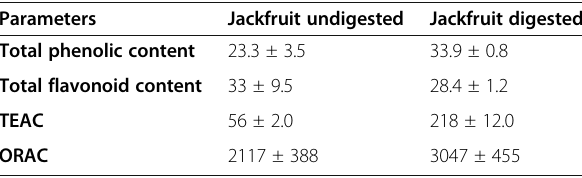
Table 2 Uses of different jackfruit parts [20, 37] Plant part Use Fruit Food: Vegetable, pickle, chutney, jam, jelly, paste, candies, juice, powder, confectionery Seed Eaten boiled, roasted and salted as table nuts, flour for baking, substrate for solid state fermentation, animal feed Jackfruit peel Adsorbent for the removal of cadmium